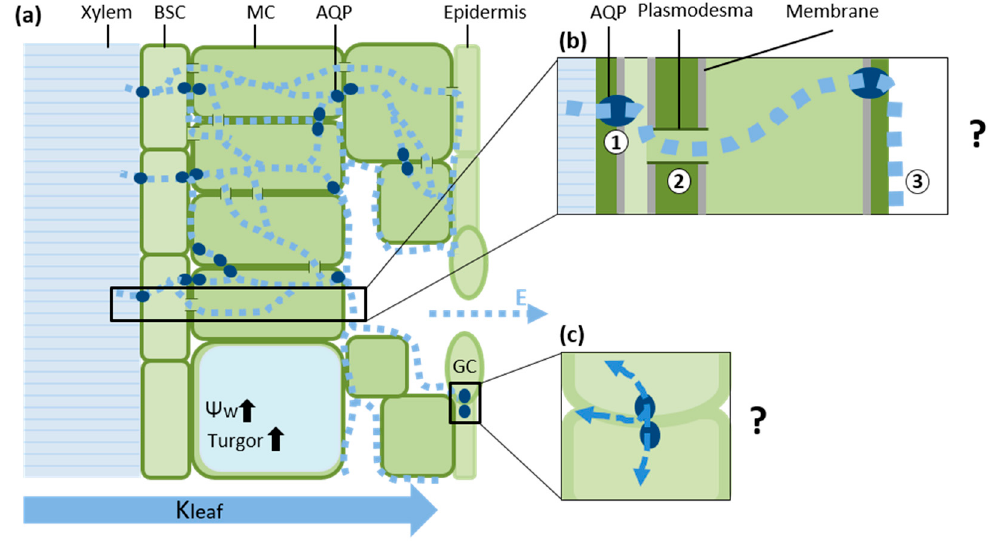
Figure 1. Composite model of water transport in the leaf. ( a ) From the vascular system, water (dashed line) is transported transcellularly via regulated Aquaporins (AQPs) into Bundle Sheath Cell (BSC). The amount of water allowed to enter the leaf is determined by hydraulic and chemical signals. If the amount of water moving out of the leaf (transpiration, E) is greater than the amount entering the leaf (via the BSC), a hydraulic signal can be induced or strengthened; ( b ) From the bundle sheath, water moves toward the mesophyll Cells (MCs) and Guard Cells (GCs) via three pathways: (1) a transcellular pathway; (2) the symplast (plasmodesmata) and (3) the apoplast. We propose that the relative amounts of water moving through each of these pathways can be altered by AQPs in response to changes in leaf water status, i.e., under optimal conditions (high water potential, Ψ W , and turgor), high levels of transpiration (E, dash line arrow) will encourage the transport of water through the apoplast by reducing the activity of AQPs in the mesophyll. In contrast, under less favorable conditions (plasmolysis, low Ψ W , and turgor), there may be an increase in AQP activity that encourages the transport of water through the symplast. However, the regulation of the distribution of water among these pathways is not yet understood; ( c ) Stomatal AQPs can affect the rate at which stomata open and close, in accordance with the turgor of neighboring cells. The destination of the liquid water that leaves the guard cells is unknown. This water may enter neighboring cells or the apoplast of the stomatal cavity, or be lost through transpiration. Hydraulic conductance of the leaf (K leaf ).